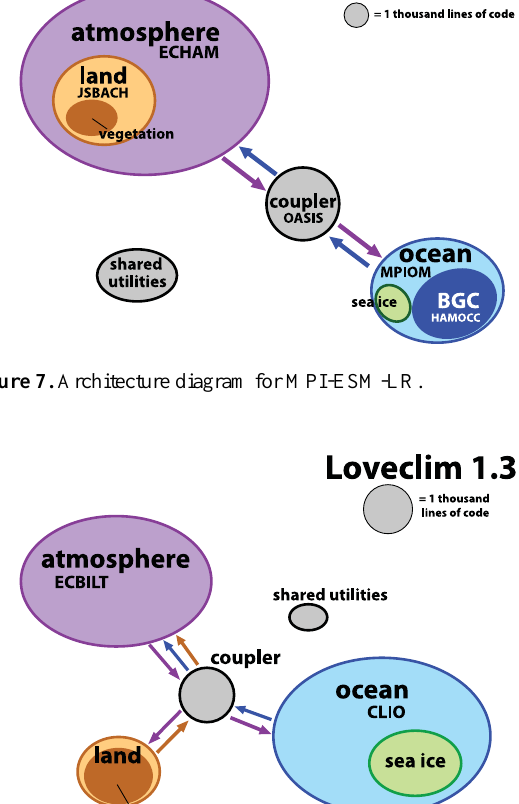
Figure 6. Architecture diagram for IPSL-CM5A-LR.